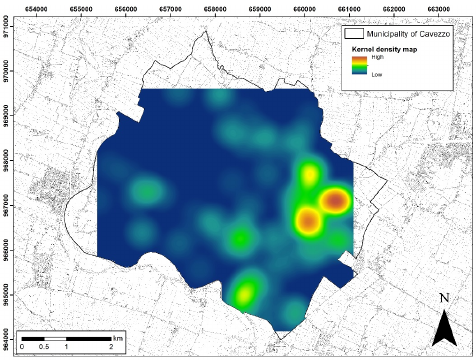
Figure 12. Kernel density map of the geotechnical investigation used to create the 3D engineering geological model of Cavezzo. The extension of the map is limited to the distribution of the available points. 5.3. Engineering Geological Units for Liquefaction Hazard Assessment (MOPS) The analysis shows that the study area is characterized by nine MOPS. The liquefia- ble layers were identified in all the MOPS, except for MOPS 9, corresponding to the allu- vial plain sector (Table 2). These liquefiable soils include sandy silts or silty sands, as well as sands mainly localized in the shallow 2–15 m from the ground level. Although the liq- uefiable layers are evident in all the MOPS, field evidence and observed co-seismic effects, after the 2012 earthquake, indicate that only MOPS 5, 6, and 7 were affected by liquefac- tion (Figure 13). In MOPS 5 and 7, silty sands and sandy silts are located between 2 and 12 m from ground level, in most cases capped by a clayey soil of about 1 m thick. Clayey deposits are not superimposed on the liquefiable deposits (such as silty sands and sandy silts), in correspondence with the MOPS 6. Even if surface manifestations of liquefaction can be evident in areas with no low permeability cap present, the 3D engineering geolog- ical model of Cavezzo displays that, in this case, the field evidence of liquefaction are observed in correspondence of silty sands and sandy silts layers in MOPS 5, 6, and 7, which are confined by clayey and silty deposits, both vertically and laterally, forming bodies that were extended not more than a few hundreds of meters in the lateral direction. These results agree with previous findings for the co-seismic liquefaction phenomenon observed in other sites in Emilia Romagna [27,44–47]. The sandy silts and silty sands lay- ers, identified in the other MOPS, where no liquefaction phenomena were detected, are continuous bodies not confined by clayey-silty deposits. Table 2. Lithological and geomorphological characteristics of the MOPS in Cavezzo. MOPS